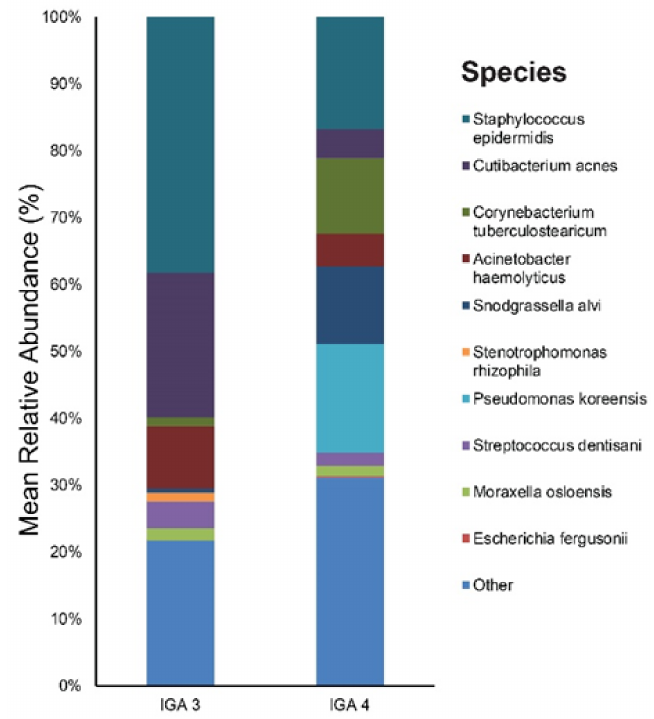
Figure 6. Bar graph on baseline skin microbiota according to rosacea severity (IGA 3 and IGA 4). We identified two genera (with relative abundance greater than 0.1% across all samples) and